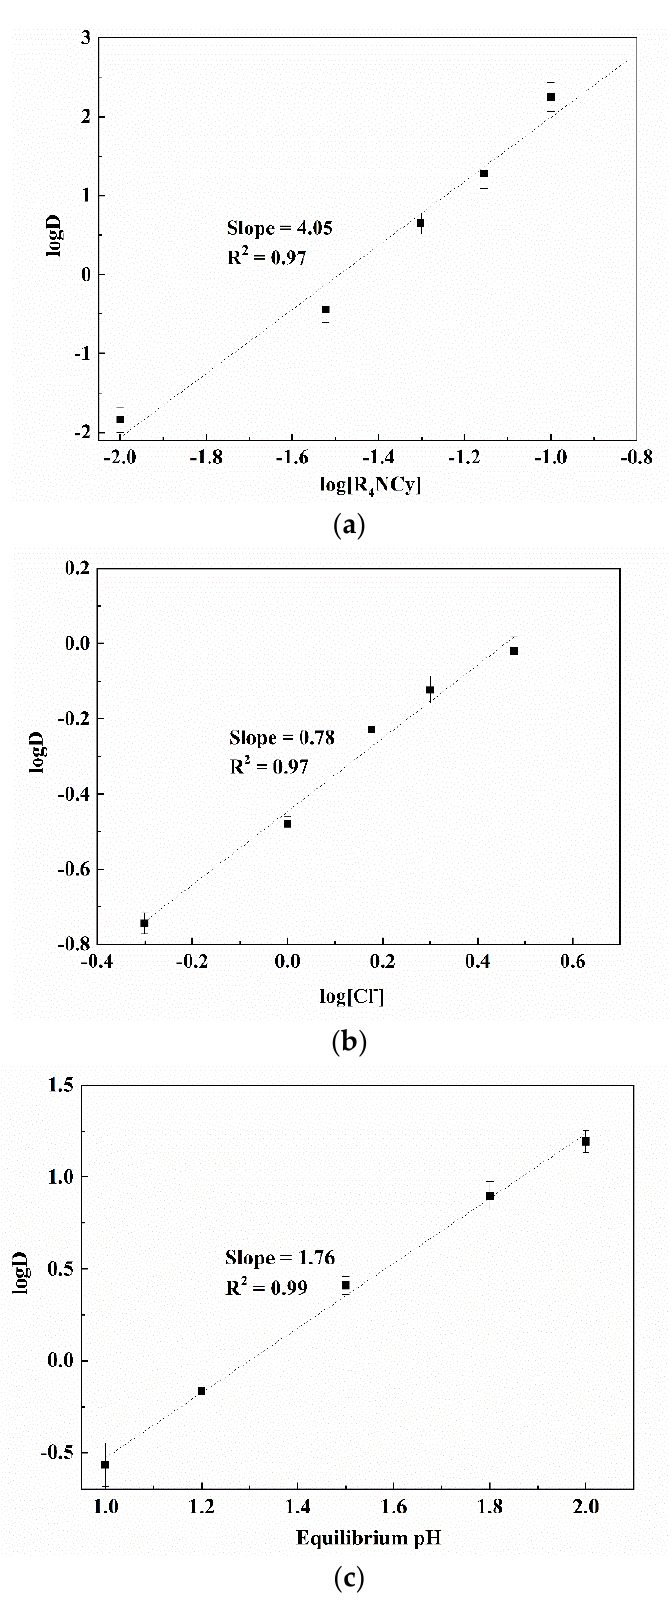
Figure 4. Effects of [R 4 NCy], [Cl − ] and equilibrium pH on the extraction of Ga(III) at low acidity. ( a )